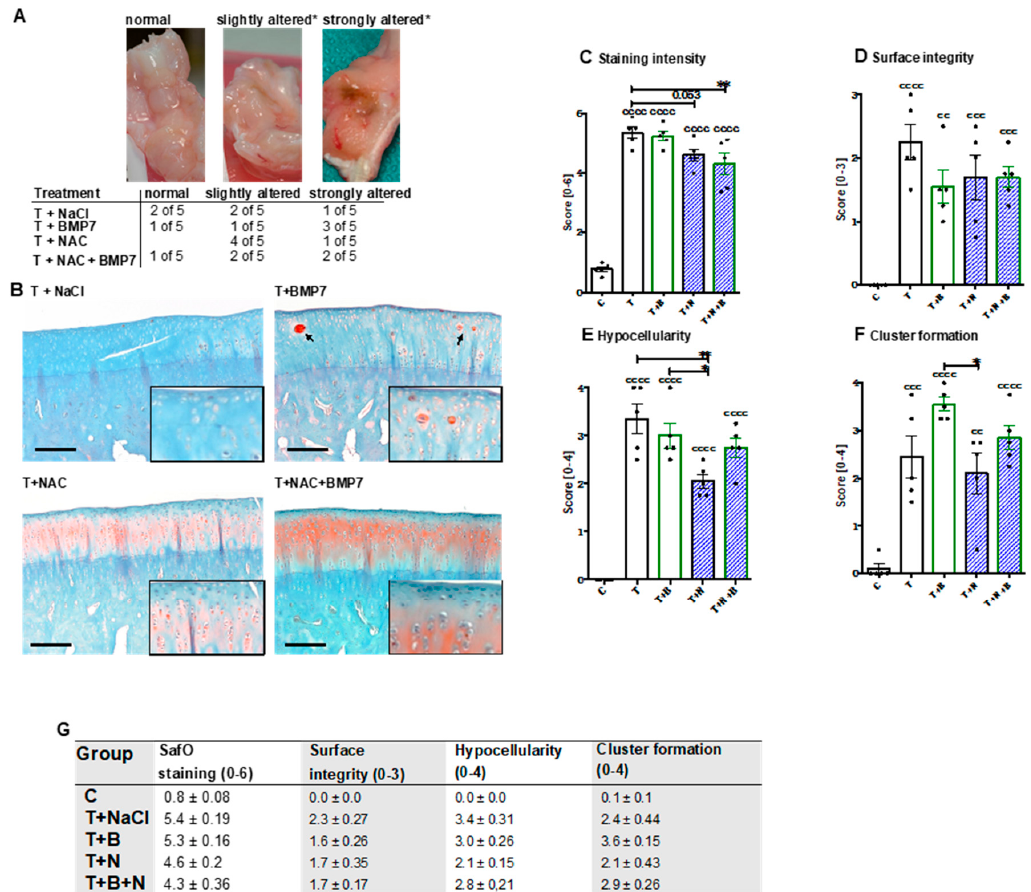
Figure 1. Macroscopic and histopathologic assessment of the joint capsule and SafO-stained condyle sections, respectively. ( A )*Alteration was defined as reddish / russet color, which was considered as possible indication of inflammatory processes or intra-articular bleeding (blood residues), and vascularization. ( B ) Exemplary images of SafO-stained medial condyles of each group. Cell clusters are indicated by black arrows. The black bar represents 100 µ m. ( C – F ) Corresponding statistical analysis of the single parameters of the histopathological assessment, charted as scattered plots with bars: ( C ) proteoglycan staining intensity, ( D ) surface integrity, ( E ) hypocellularity, and ( F ) cluster formation. ( G ) Values of the single criteria given as mean ± SEM; n = 5. Statistically significant di ff erences between groups were depicted as: [vs C] cc: p < 0.01, ccc: p < 0.001, and cccc: p < 0.0001; [vs. T] *: p < 0.05, and **: p < 0.01. T = trauma, T + B = traumatized and BMP7-treated, T + N = traumatized and NAC-treated, T + N + B = traumatized and BMP7- plus